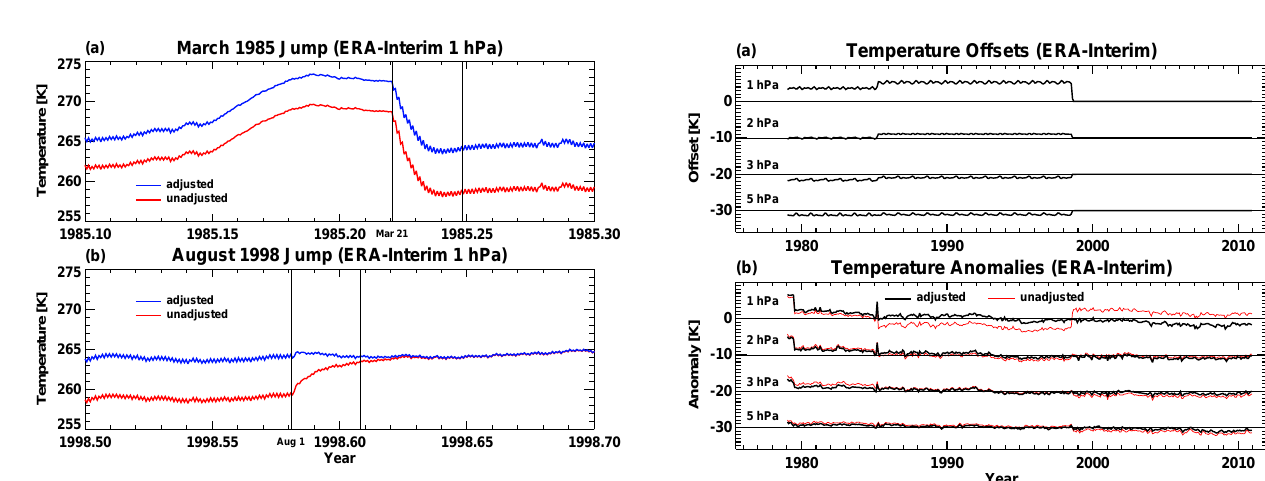
Fig. 4. Global and monthly mean (a) temperature offsets that are applied to the ERA-Interim data and (b) temperature anomalies for the adjusted (black) and unadjusted (red) ERA-Interim data. The curves at 2, 3, and 5hPa are shifted by 10K with respect to the curve